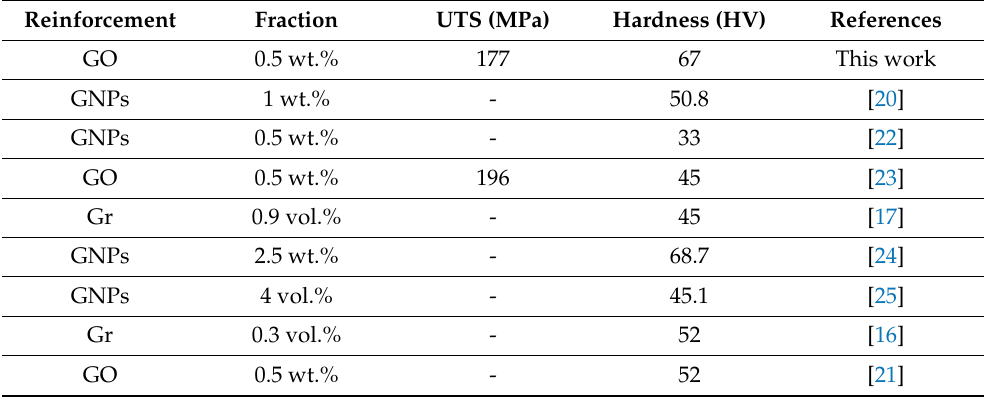
Table 1. Ultimate tensile strength (UTS), Vickers hardness (HV) of various Cu matrix composites with Cu-GO